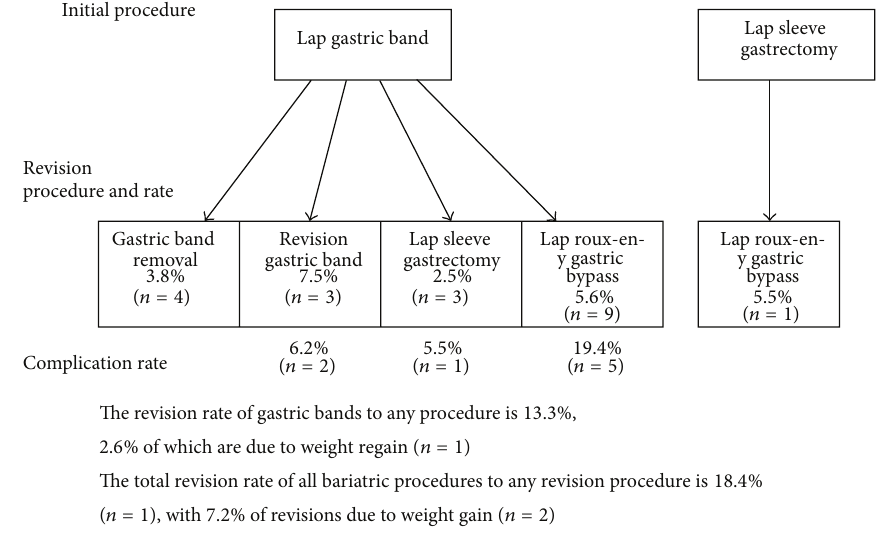
Figure 2: Average rate of bariatric surgery